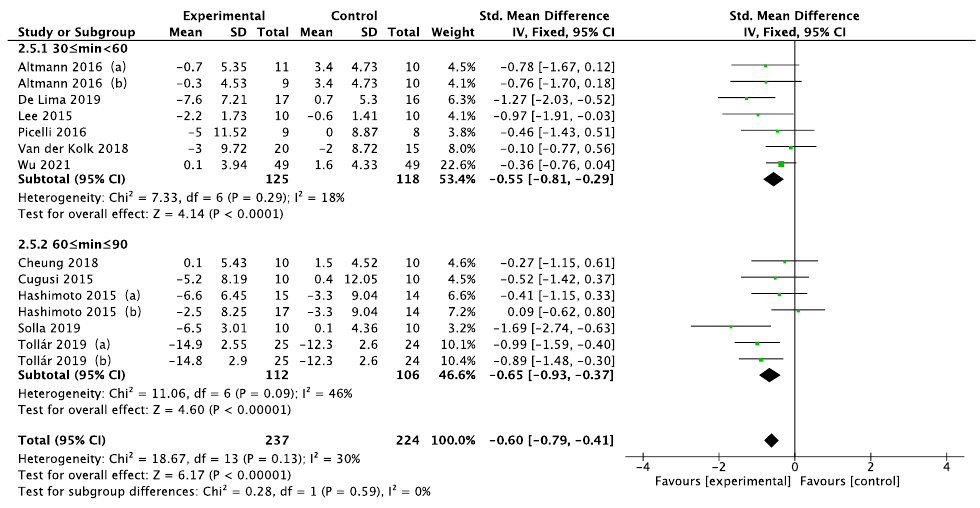
Figure 8. Subgroup analysis of intervention frequency [24,25,33–41].